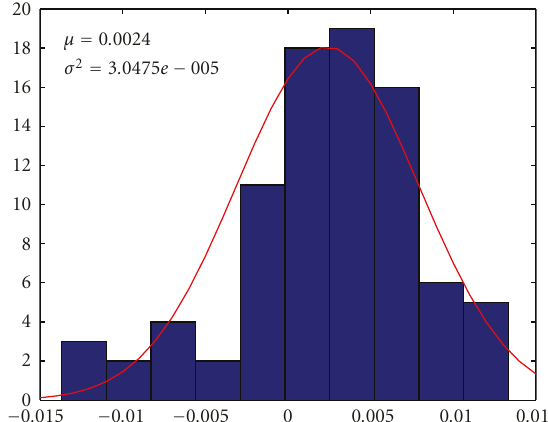
Figure 10: The histogram of estimated measurement noise. The red line represents fitted Gaussian